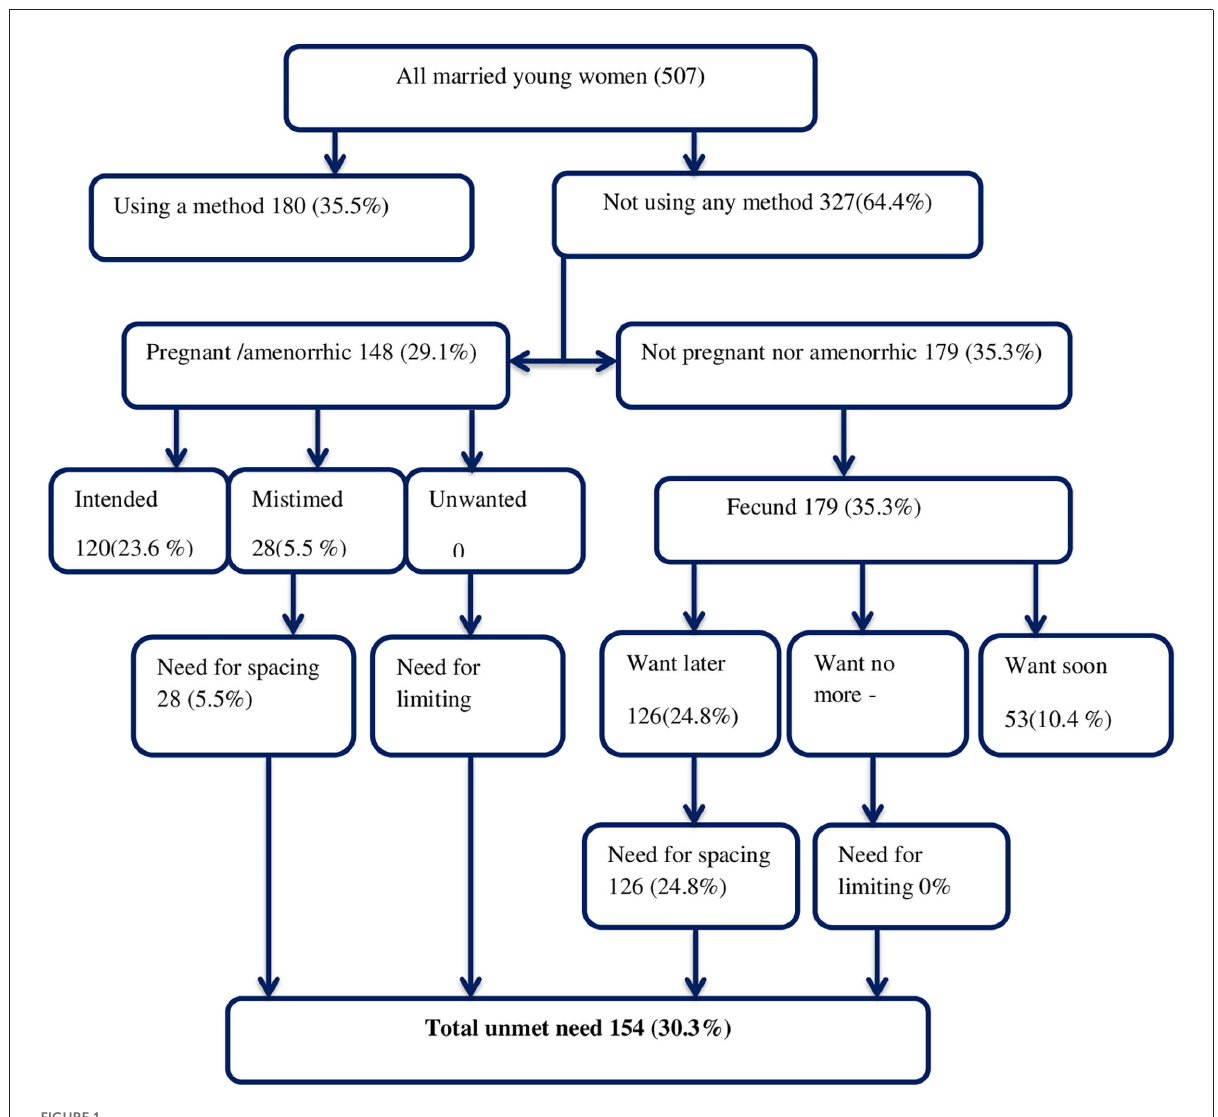
FIGURE1 Algorithm of unmet need for contraception among young married women in the Haramaya HDSS, eastern Ethiopia, 2020.